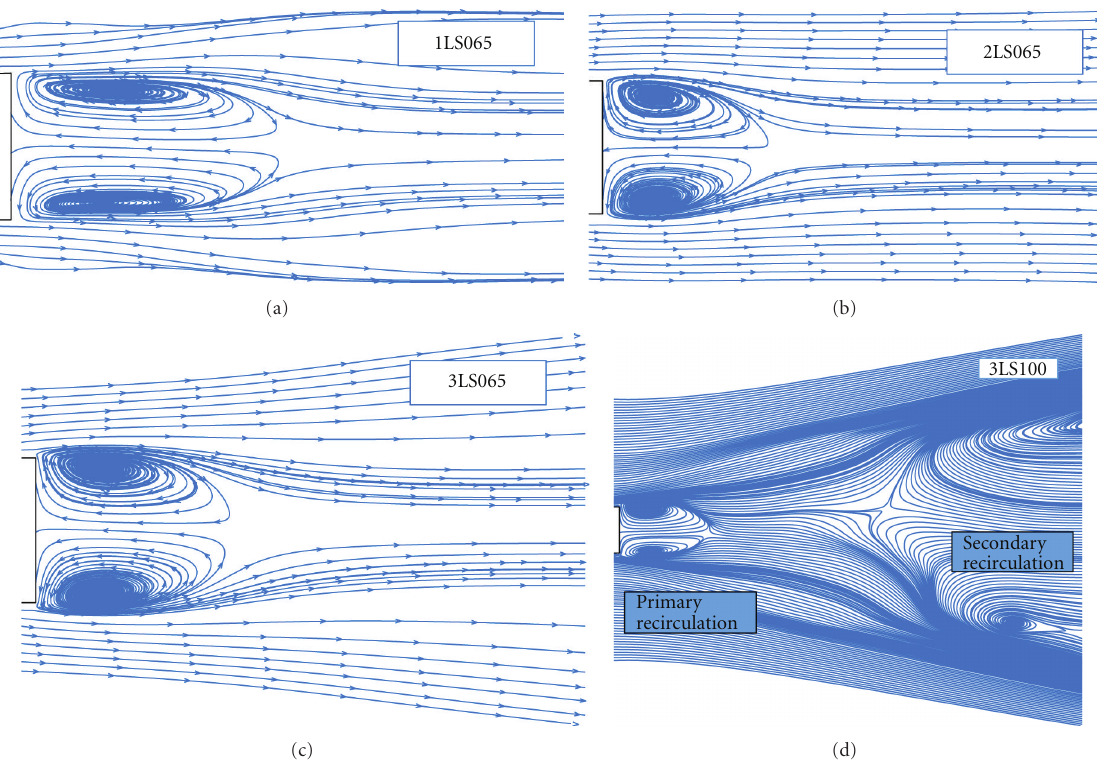
Figure 5: Axisymmetric wake flow fields for the three burner